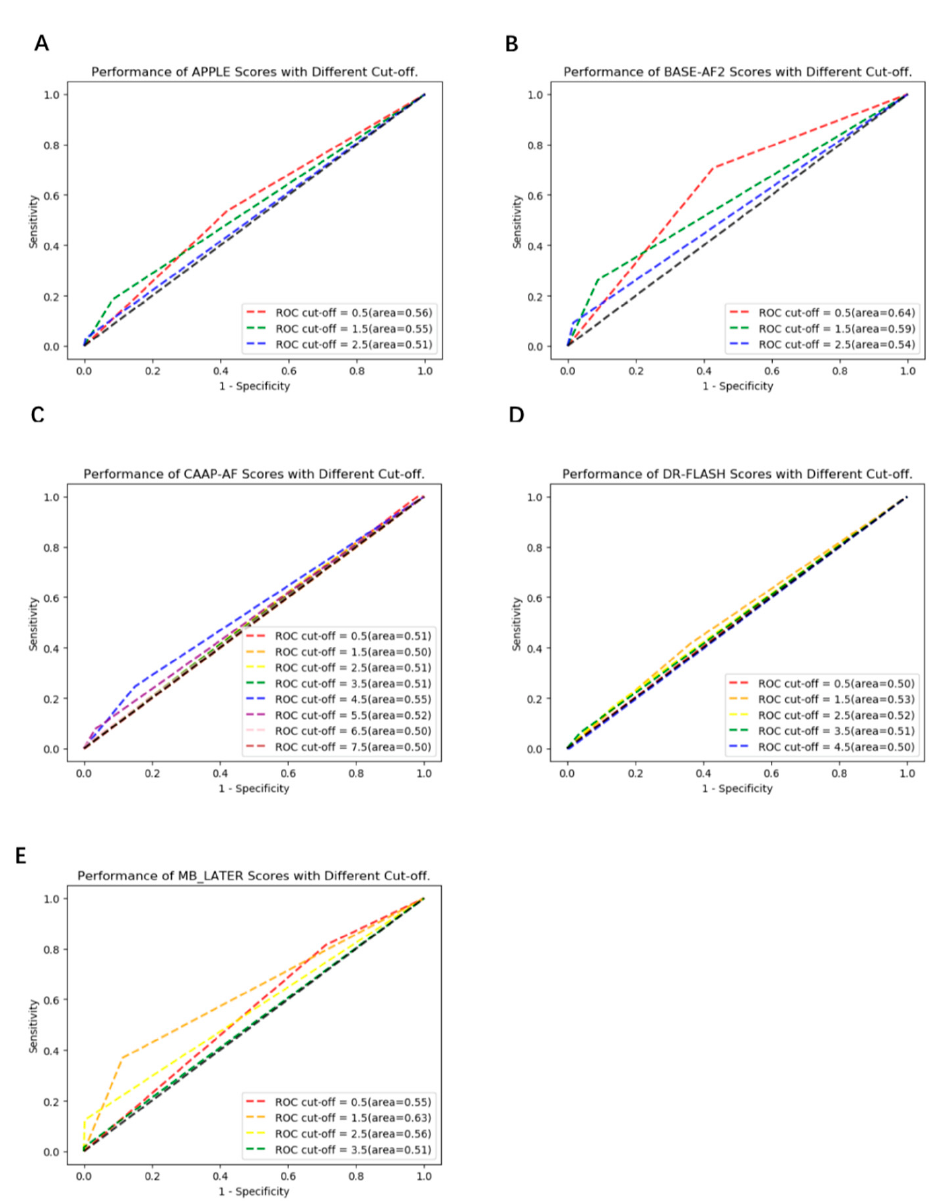
Figure 4. The Predictive Performance of Different Models. ( A ) the AUCs of APPLE, ( B ) the AUCs of BASE-AF2, ( C ) the AUCs of CAAP-AF, ( D ) the AUCs of DR-FLASH, ( E ) the AUCs of MB-LATER. The clinical prognostic factors were used to predict the risk of recurrence, and the AUCs were shown (Figure 5). The AUC of left atrial enlargement for predicting recurrence was 0.61 (95% CI: 0.55–0.67) with sensitivity, specificity, accuracy, precision and F1 score of 36.9%, 85.2%, 78.8%, 27.9% and 0.32, respectively. While that of early recurrence was 0.68 (95% CI: 0.62–0.75) with sensitivity, specificity, accuracy, precision and F1 score of 44.6%, 92.4%, 86.0%, 47.5% and 0.46, respectively (Table 3). Compared with the prognostic factors, the predictive performance of the CNN model was also better (0.84 vs. 0.61 and 0.68, p <